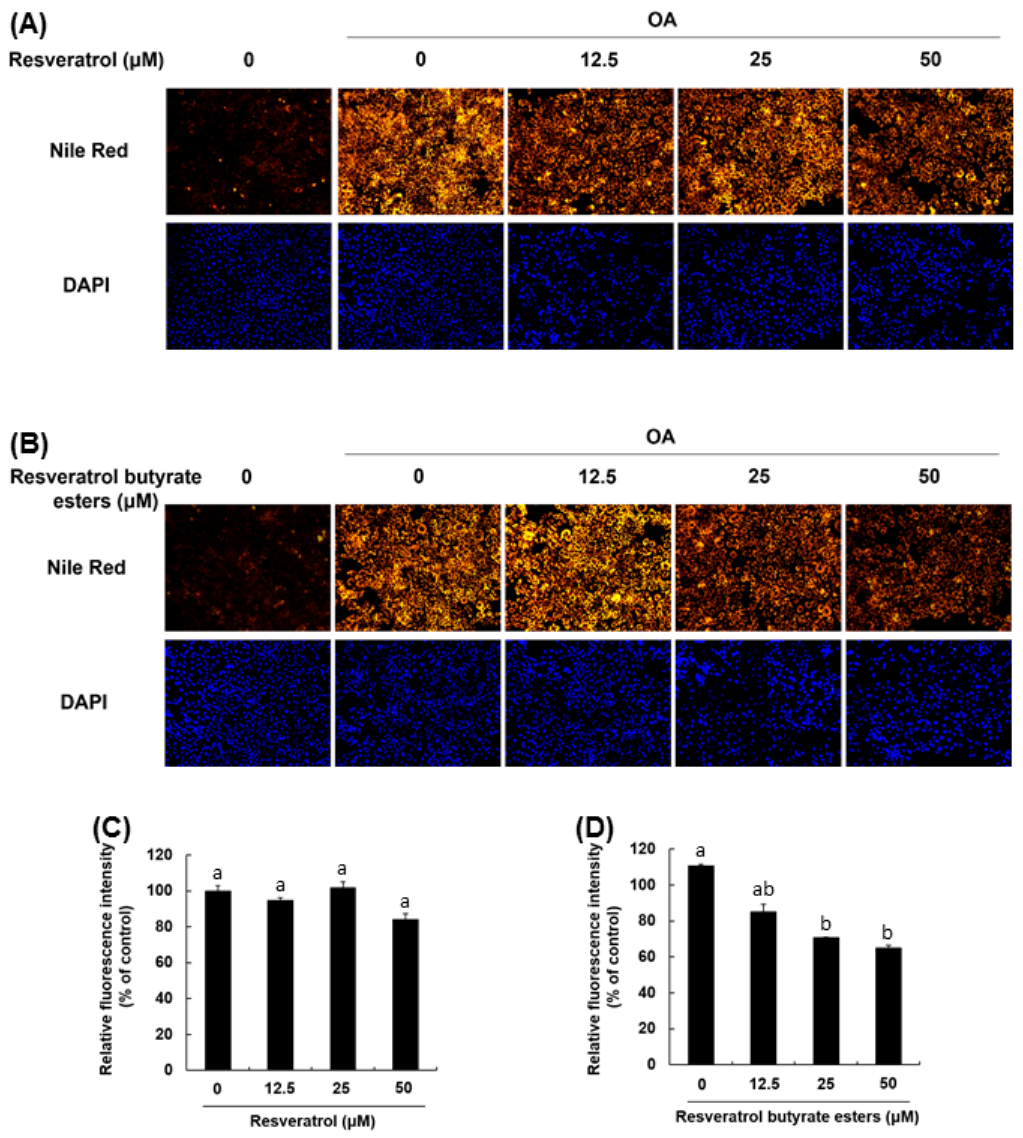
Figure 6. Effect of resveratrol and RBE on fat accumulation in HepG2 cells induced by treatment with 400 μ M oleic acid. Nile red and DAPI stained cells treated with resveratrol (RE) ( A ) or RBE ( B ). Relative fluorescence intensity (% of control) at different RE concentrations ( C ). Relative fluorescence intensity (% of control) at different RBE concentrations ( D ). n = 3 per group. a–b p < 0.05 compared to the control .